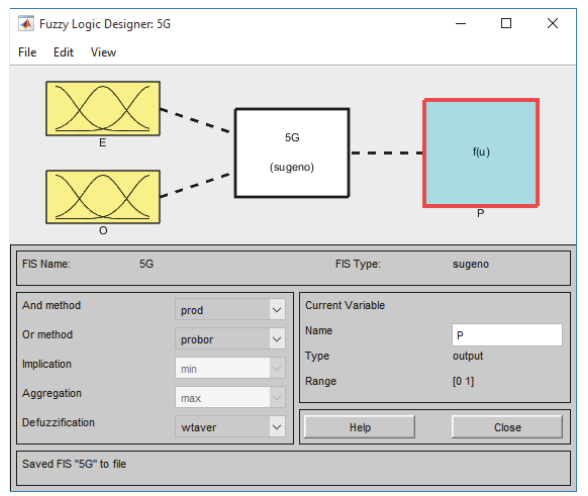
Figure9:Simulationresults.Probabilityforcallacceptationis-60%. It means the call is likely to be transferred to another operator.